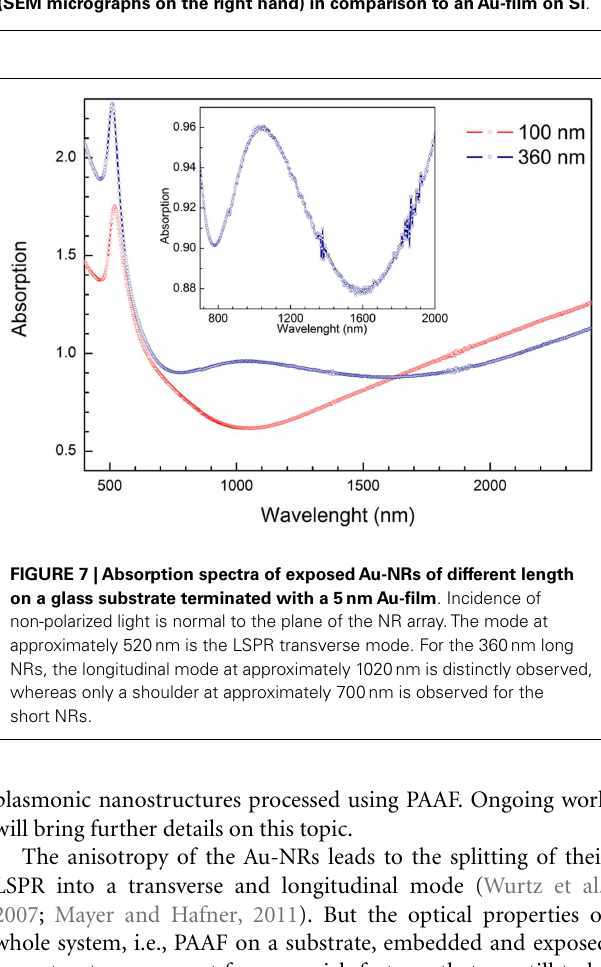
FIGURE 6 | Diffuse reflectance spectra of emptyAAO and embeddedAu-NRs (SEM micrographs on the right hand) in comparison to anAu-film on Si .